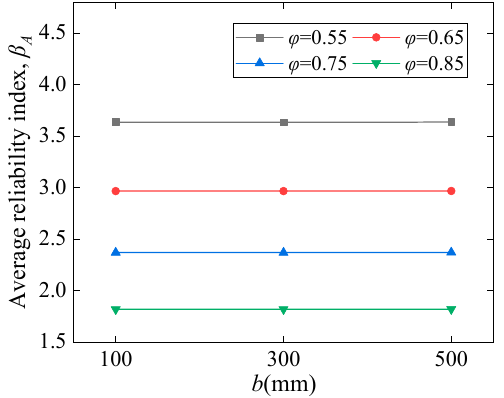
Figure 13. Geometrical dimension effects.